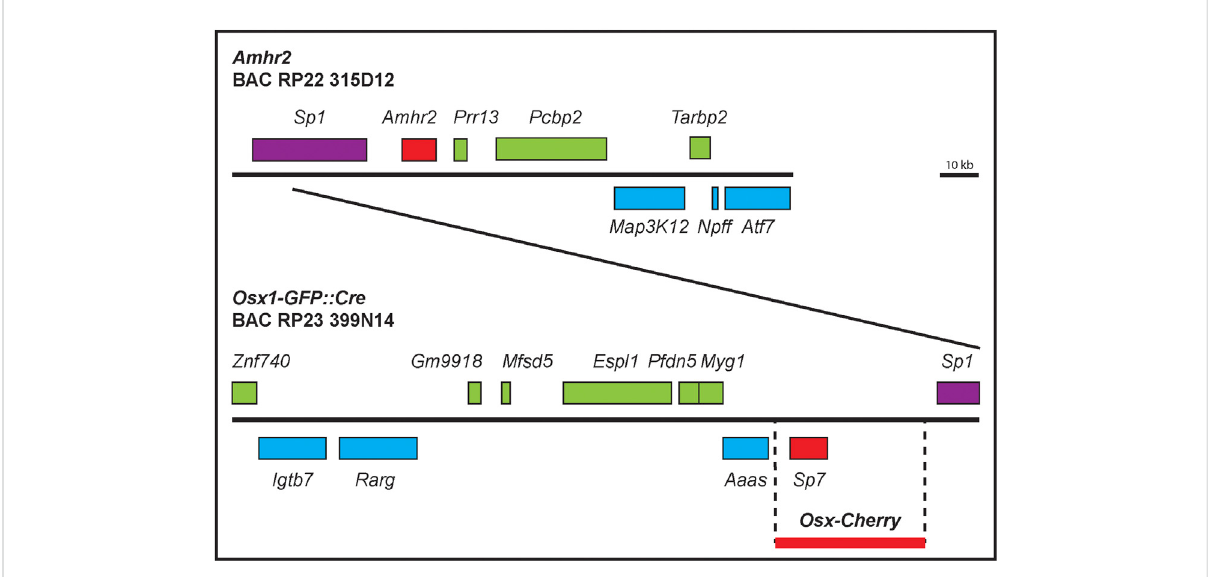
FIGURE 1 Amhr2 -and Osx -containing BAC clone maps. Diagram of the genomic regions contained within BAC clones RPCI-22 315D12 and RP23- 399N14. Genes (introns and exons) are represented by boxes above or below the line, representing the location of the genes on the two strands of DNA. The ~39 kb region used to create Osx-Cherry mice is also shown (thick red line) that lacks coding sequences from neighboring genes.